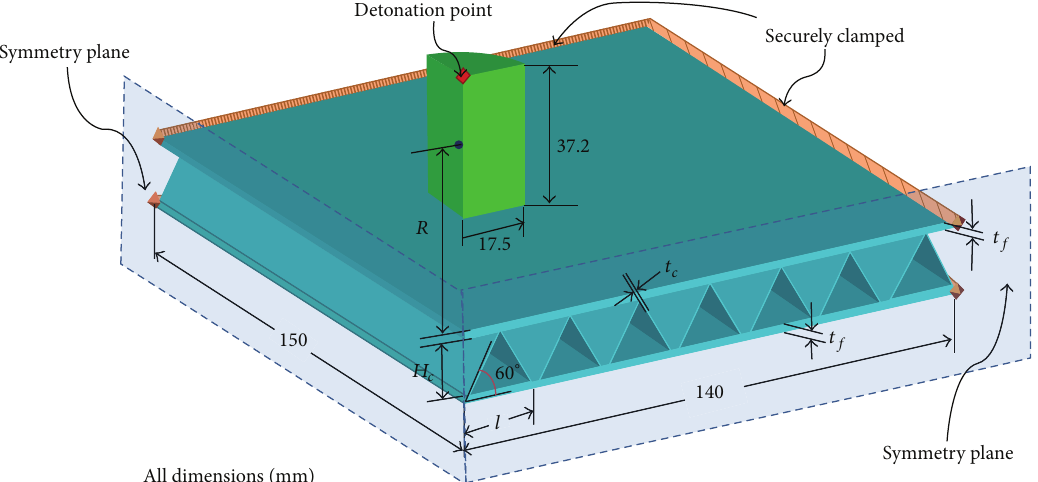
Figure 1: Geometric models of the one-quarter corrugated sandwich panel and the one-quarter cylindrical